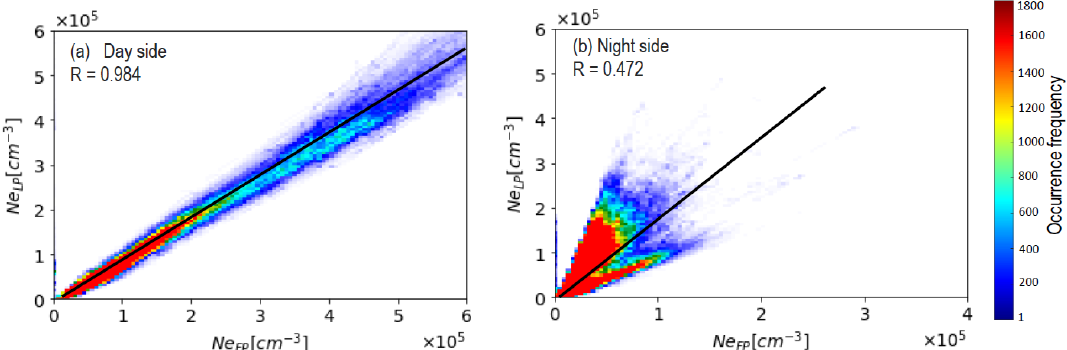
Figure 8. Comparison of the plasma density derived from the LP and FP on the (a) day side and the (b) night side as measured by Swarm C in February 2020. The black lines represent the linear fit obtained for the two datasets.